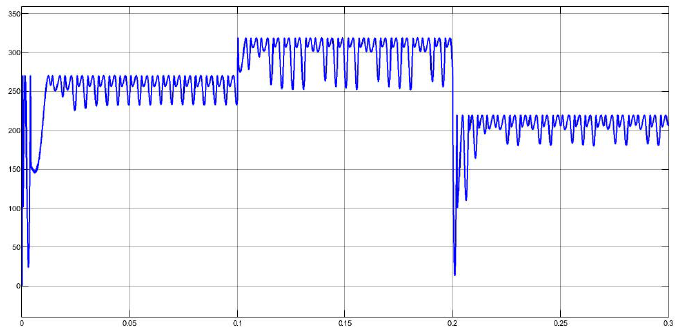
Figure 17. Performance of P&O MPPT (large step size).